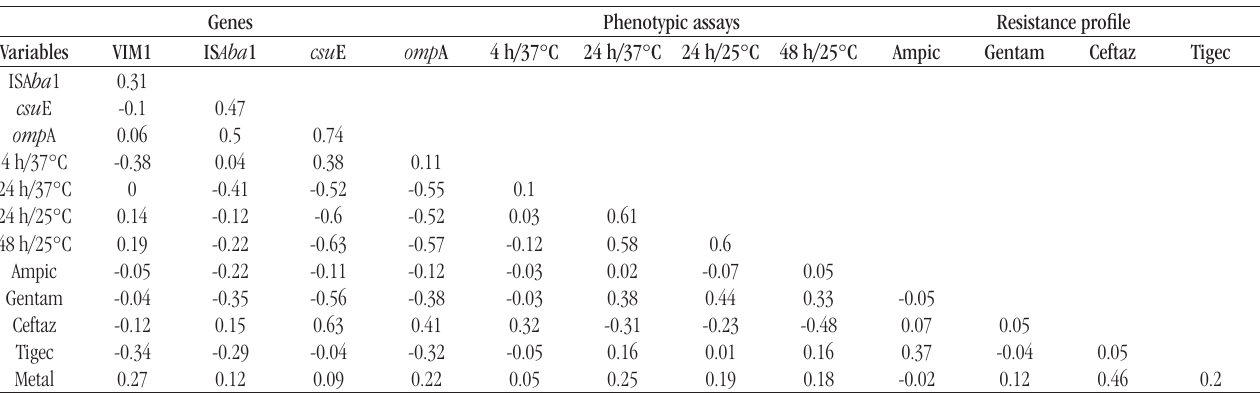
taBLE 2 − Correlation matrix between the variables